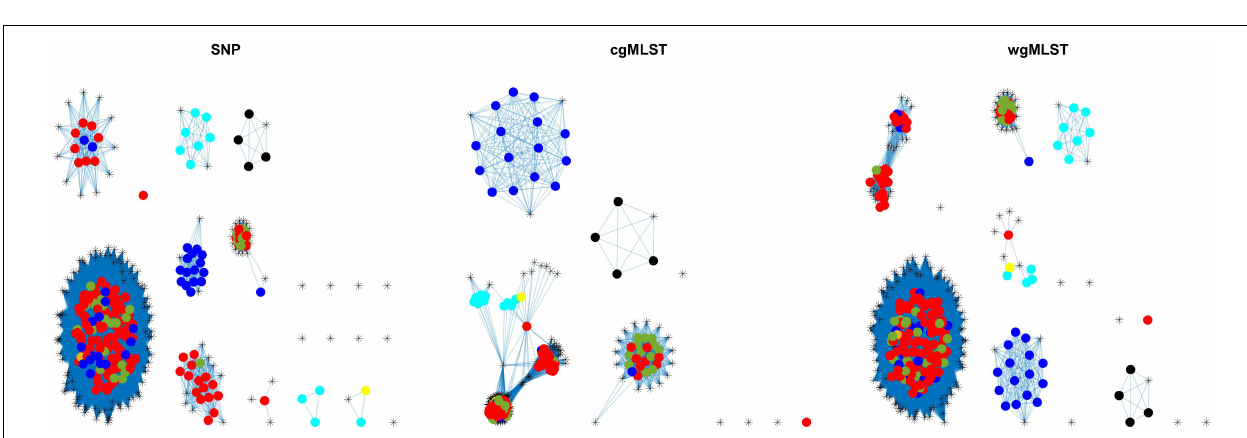
FIGURE 5 | Source attribution results (force-directed graph drawing algorithm) obtained by SNP, cgMLST, and wgMLST distance matrices. Legend: pigs from Denmark, red; import pigs, green; broilers, blue; cattle from Denmark, darker yellow; import cattle, lighter yellow; ducks, cyan; layers, black; humans, asterisk.